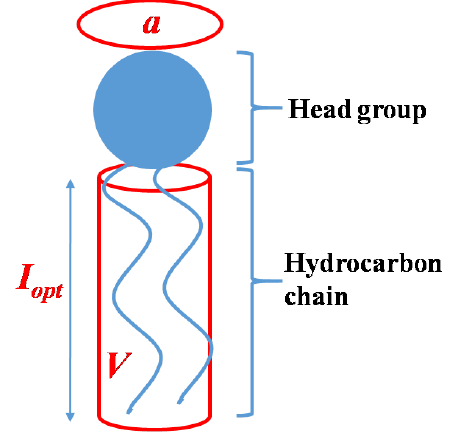
Figure 1 : Packing parameters of phospholipid